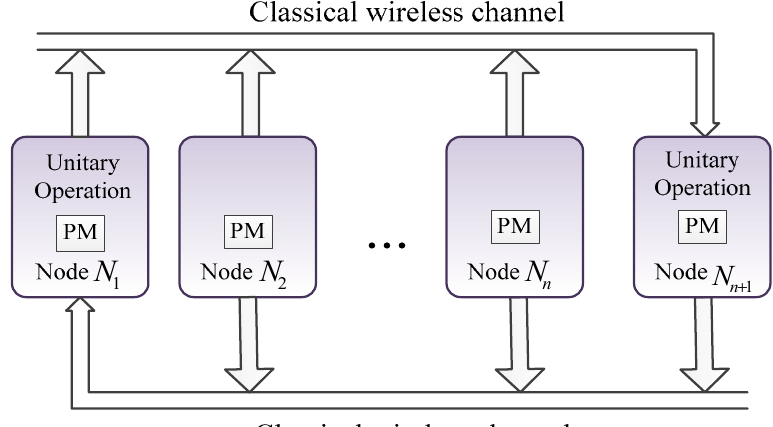
Figure 7. The proposed scheme in this paper.